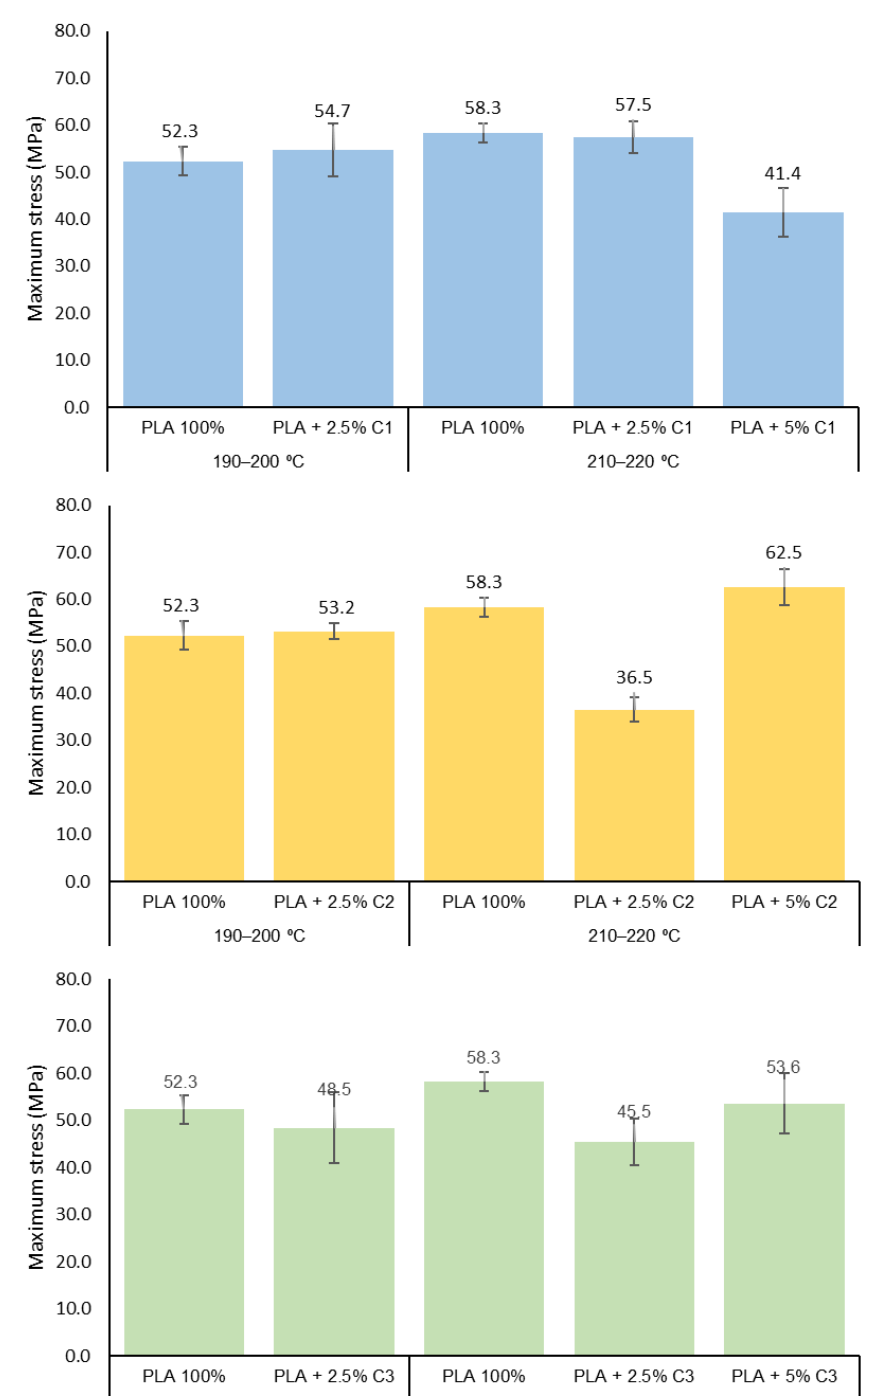
Figure 5. The maximum stress of PLA 100%, PLA + 2.5% and PLA + 5% concentrations of compatibilizer samples extruded at 190–200 ◦ C and 210–220 ◦ C.